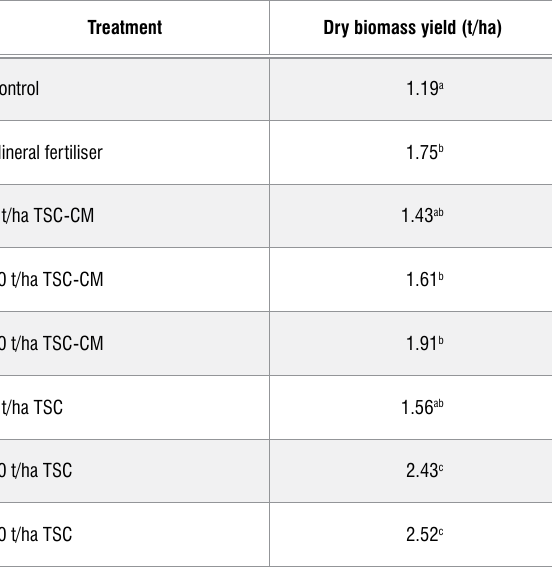
Cumulative dry mass yield of oilseed rape ( Brassica napus L.) 9 weeks after transplanting